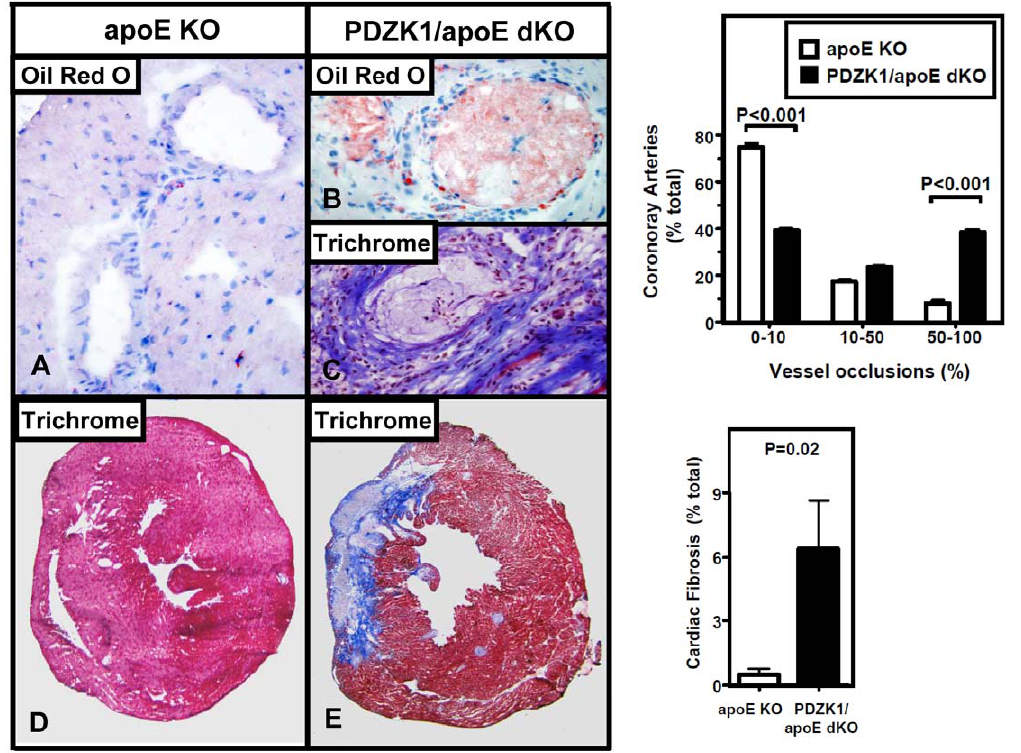
Figure 4. Effects of loss of PDZK1 on coronary atherosclerosis and cardiac fibrosis in apoE KO mice. Hearts were harvested from Paigen diet-fed mice as described in Methods (n=8 per genotype). Left panels: A–B: representative cross-sections of Oil red O-stained (A–B) or trichrome- stained (C) myocardial coronary arterioles, showing unremarkable arterioles in apoE KO (A) and totally occluded arterioles in PDZK1/apoE dKO (B–C) mice (magnification, 6 100). The Oil red O stain shows that the coronary arteriole is occluded almost exclusively by lipid-rich lesions (B), while the trichrome stain shows that the arteriole is surrounded by fibrosis in an area of myocardial infarction in a PDZK1/apoE dKO mouse (C). D–E: trichrome stained sections of hearts showing areas of infarction/fibrosis stained blue in PDZK1/apoE dKO (E), while they are absent in apoE KO (D) mice (magnification, 6 10). Right top panel: quantification of coronary artery occlusions in apoE KO and PDZK1/apoE dKO mice. Statistically significant differences by ANOVA Tukey posthoc test comparing the two genotypes within a given group are indicated as: P , 0.001. Right bottom panel: quantification of cardiac fibrosis in apoE KO and PDZK1/apoE dKO mice. Unpaired Student’s t-test was used to determine statistical significance.